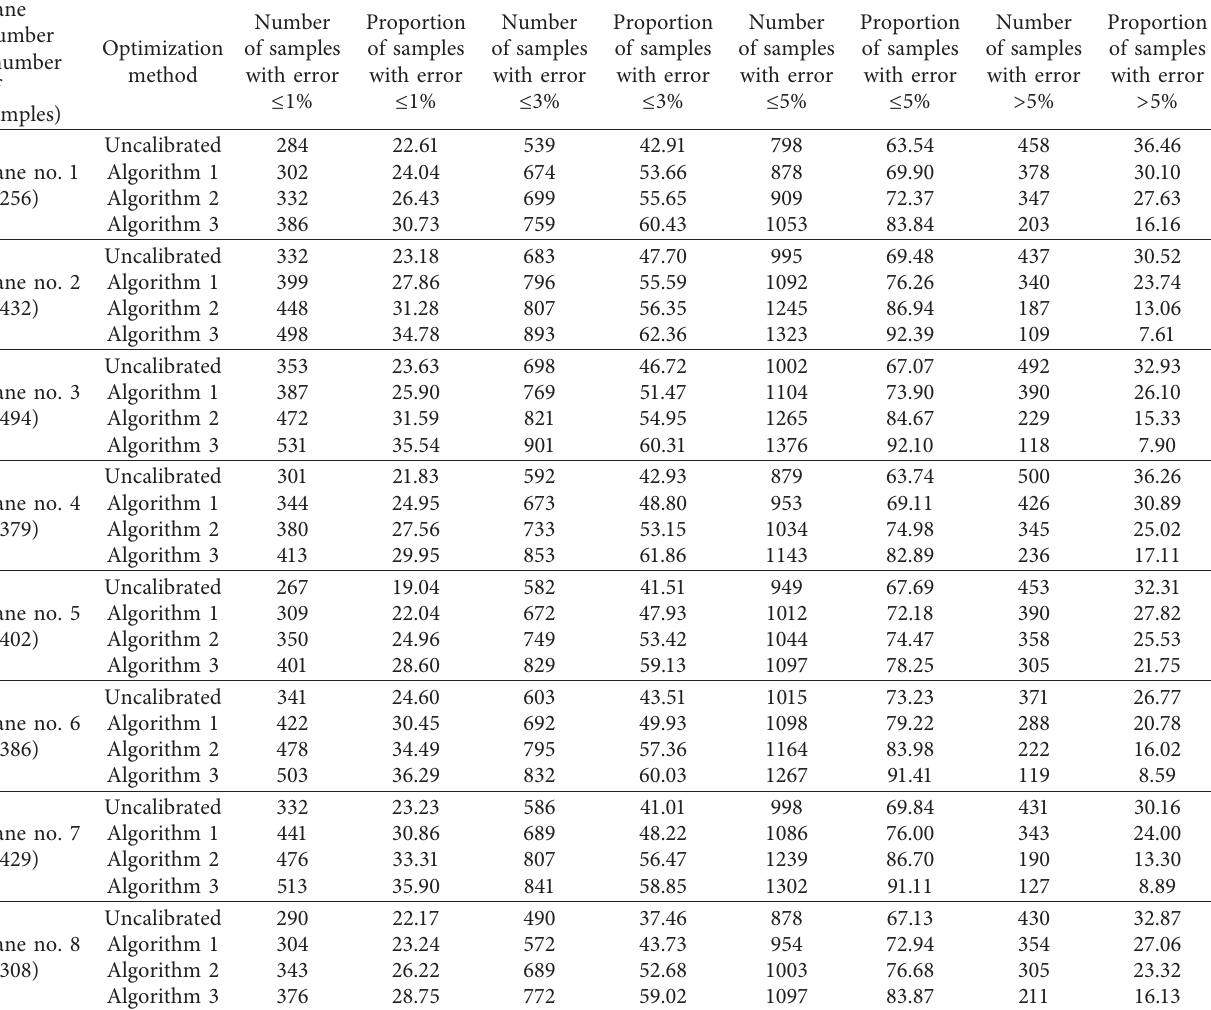
Table 1: The calibration results of detected velocity values under different algorithms.